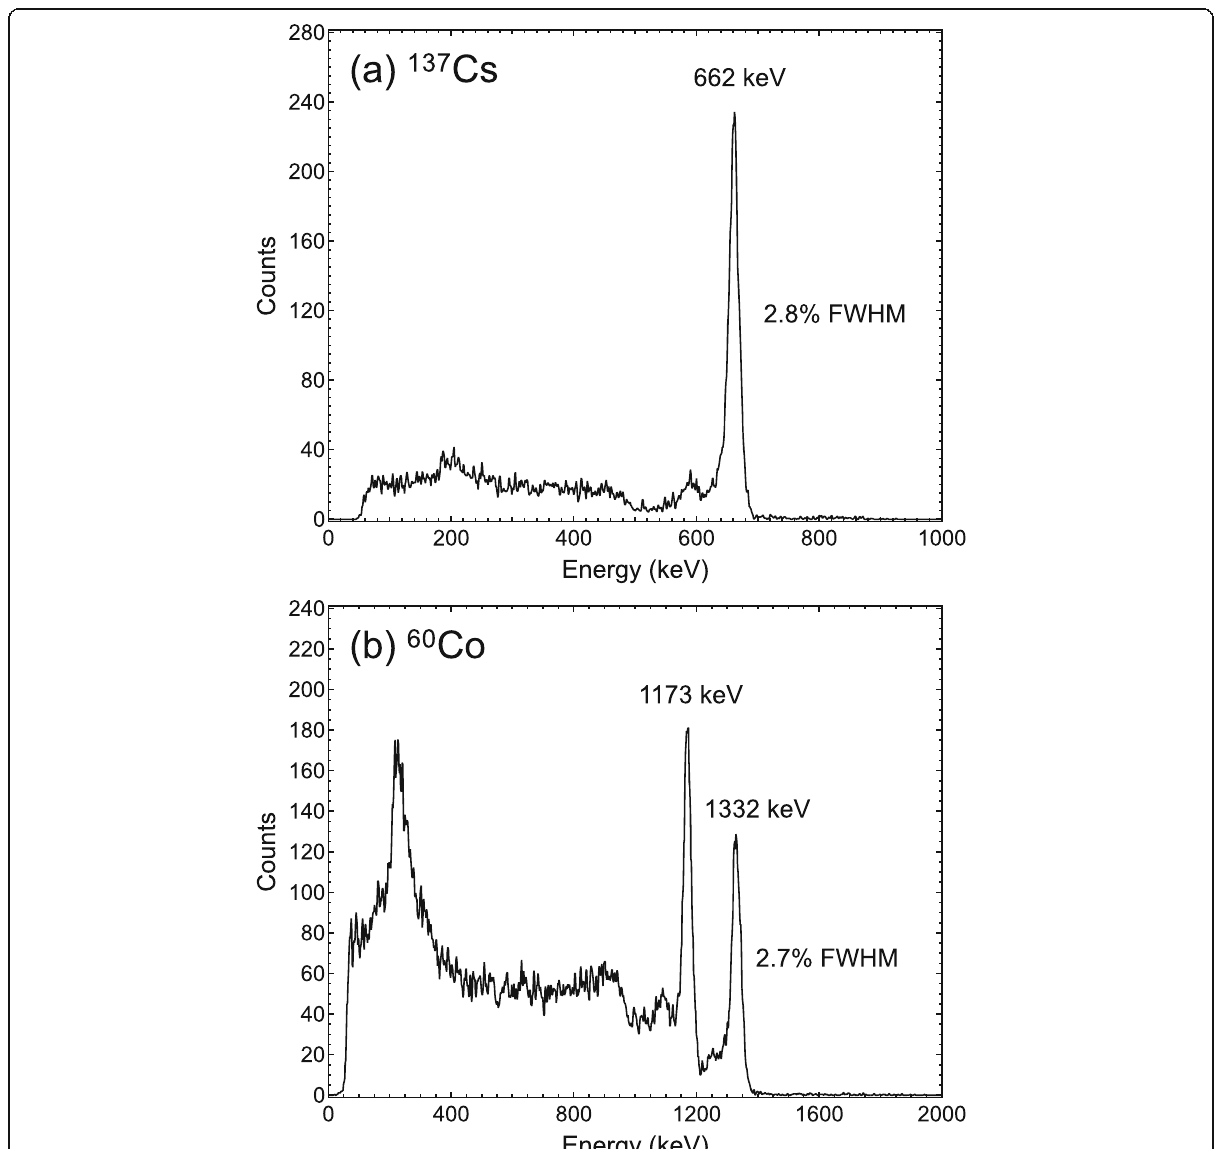
Fig. 4 137 Cs ( a ) and 60 Co ( b ) gamma-ray spectra obtained from a 1-cm-thick TlBr detector with depth correction and rejection at room